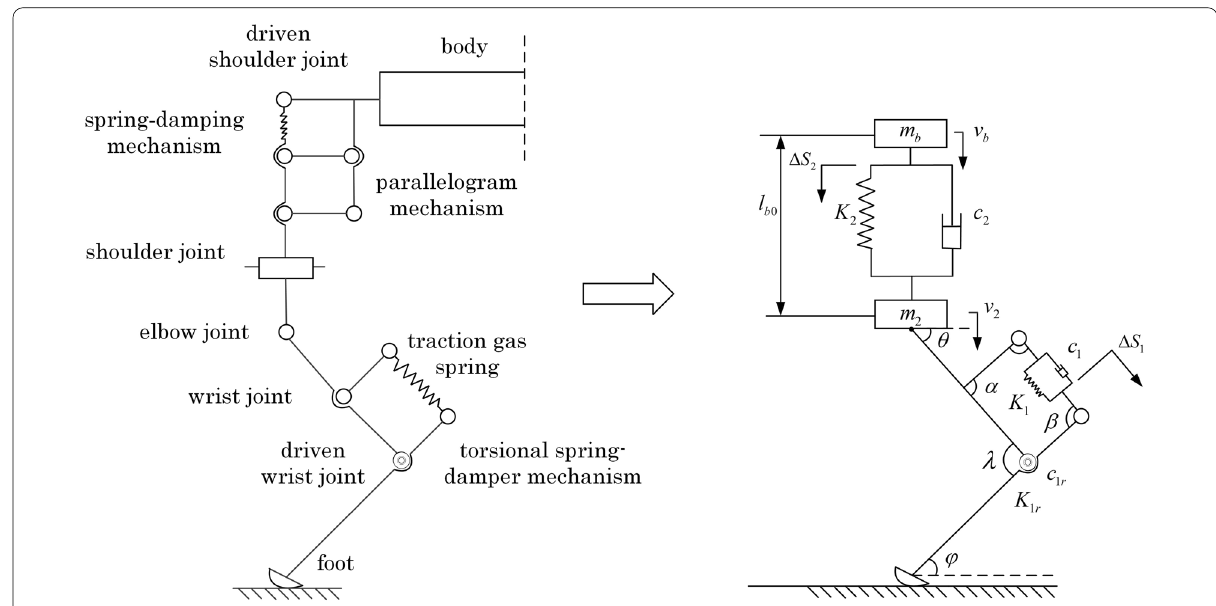
Figure 18 Equivalent model of the multistage buffer system